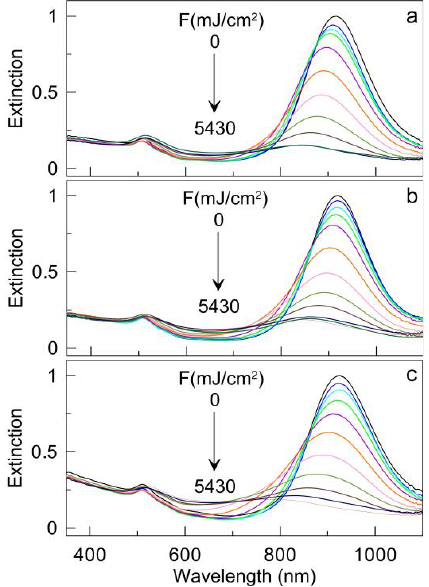
Figure 9. Extinction spectra of gold nanorods coated with a silica shell with an average thickness of 24 ( a ), 30 ( b ), and 57 nm ( c ) before (black curve) and after PM under the action of a pulsed laser with fluence from 13 to 5430 mJ/cm 2 when moving through the capillary. The fluence values are (from top to the bottom) 0, 13, 40, 65, 130, 260, 520, 1040, 2080, 4160, and 5430 mJ/cm 2 . For a silica shell thickness of 30 nm (AuNR@SiO 2 -30), a noticeable initial PM also occurs at a fluence of 130 mJ/cm 2 (Figure 9b). With a further increase in fluence from 260 to 4800 mJ/cm 2 , similar changes occur in the spectrum: the LPR peak decreases, broadens, and shifts towards shorter wavelengths up to about 850 nm. For the maximum shell